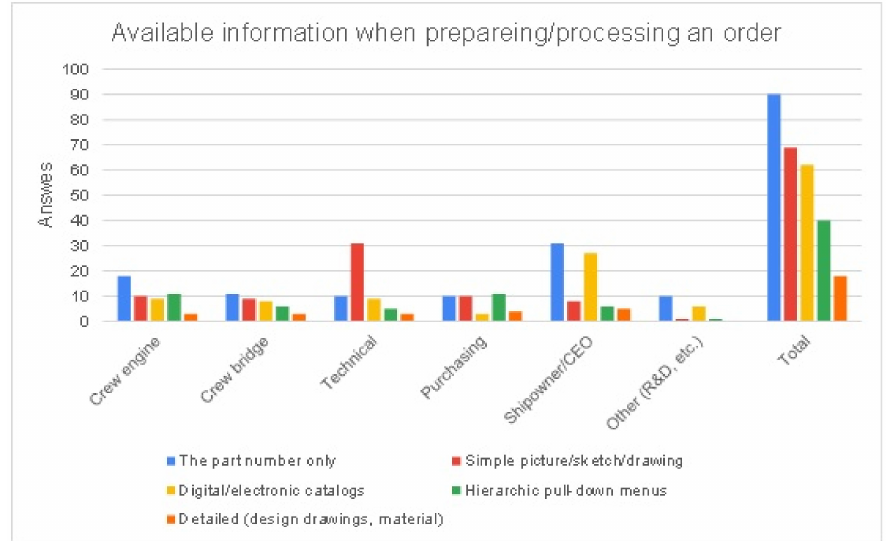
Figure 12. Available information when preparing/processing an